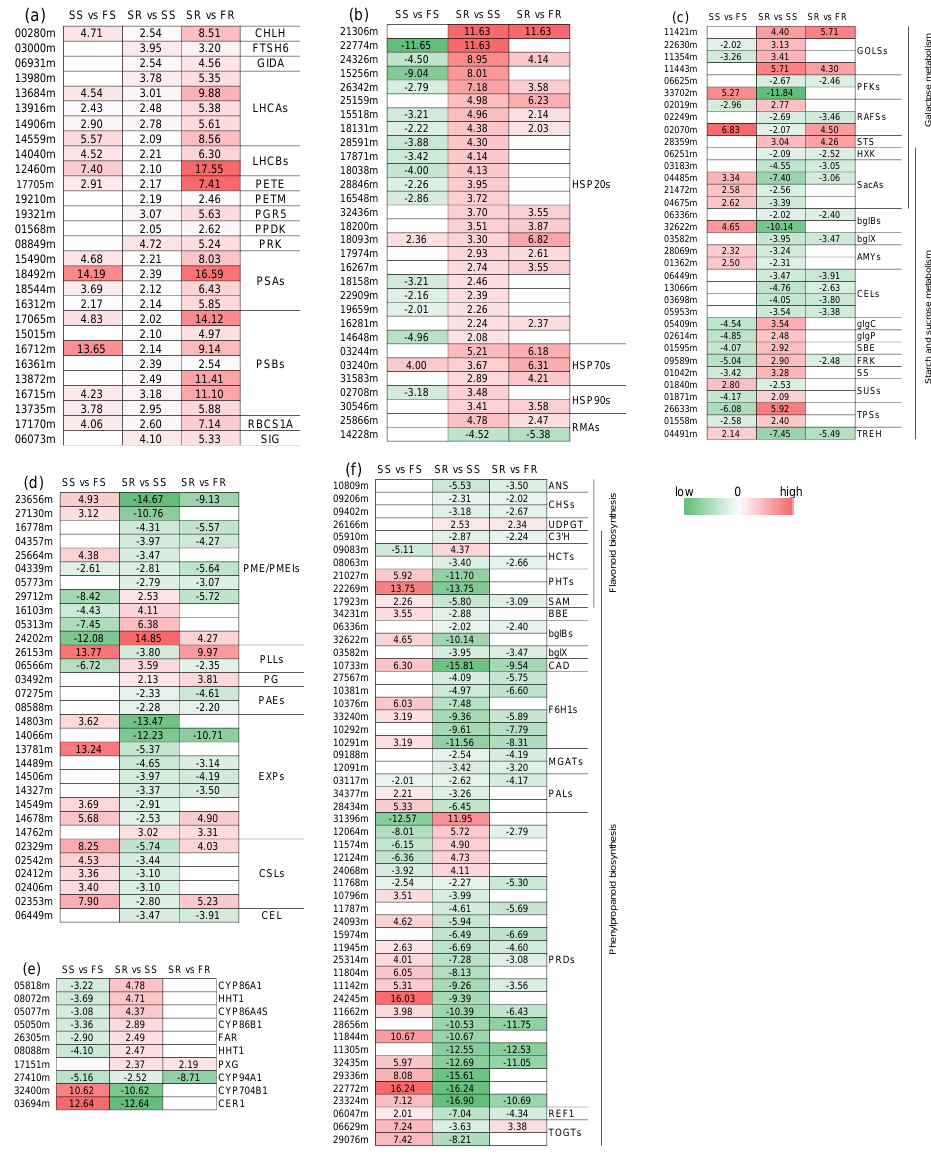
Figure 6. Heatmap of differentially expressed genes related to photosynthesis ( a ), protein processing in endoplasmic reticulum ( b ), galactose metabolism and starch and ( c ), cell wall ( d ), cutin, suberin and wax biosynthesis ( e ) and phenylpropanoid biosynthesis and flavonoid biosynthesis ( f ).